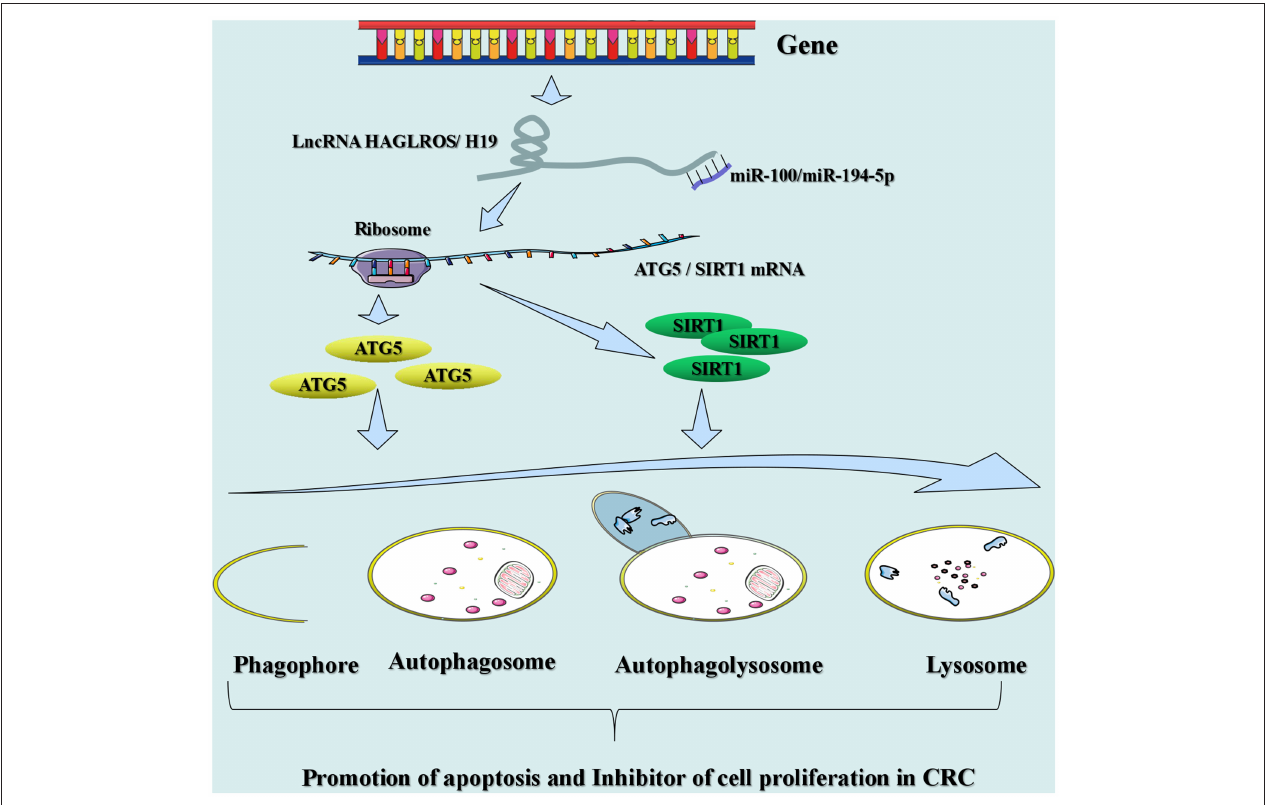
FIGURE 2 | Summary of lncRNAs involved in the biological function of